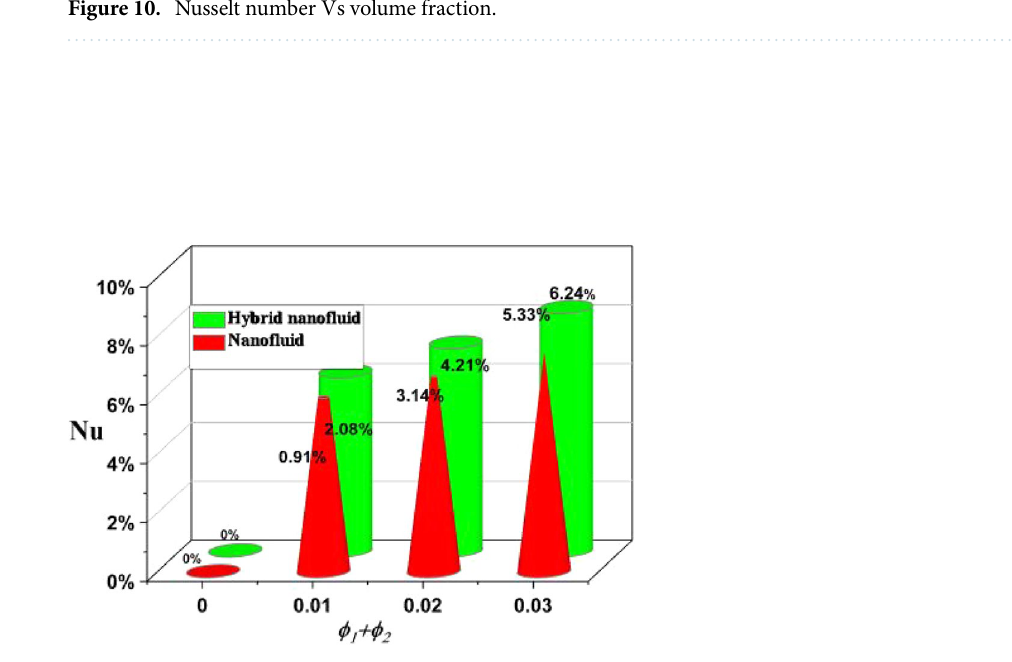
Figure 11. Percent improvement of heat